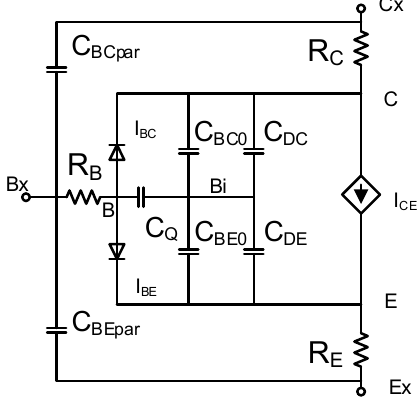
Figure 2. Equivalent circuit of the Graphene Base Transistor (GBT) electrical compact